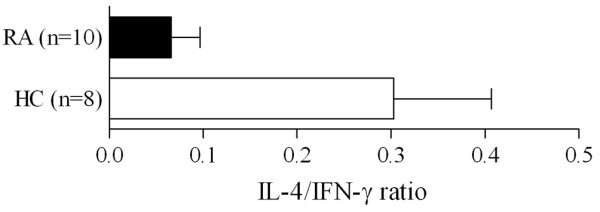
IL-4/IFN-γ ratio in α-galactosylceramide (α-GalCer) stimulated peripheral blood mononuclear cells (PBMCs) evaluated by ELISPOT. PBMCs (2 × 105 cells/well) from 10 rheumatoid arthritis patients and eight healthy control individuals were stimulated with α-GalCer or no antigen for 20 hours. The number of cytokine secreting cells was calculated by subtracting the number of spots in control wells (without antigen) from the number of spots obtained in the presence of each stimulating agent. The IL-4/IFN-γ ratio is the number of IL-4 producing cells divided by the number of IFN-γ producing cells. Error bars indicate standard error of the mean.